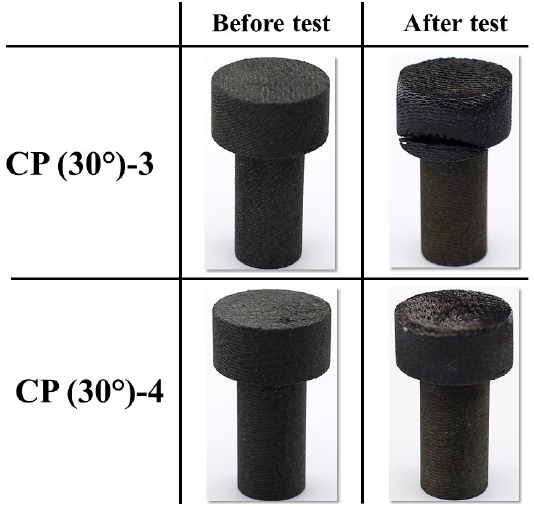
Figure 14. CP (30°)-3 (9 MW/m 2 , 30 s) and CP (30°)-4 (11.5 MW/m 2 , 30 s) before and after test images.